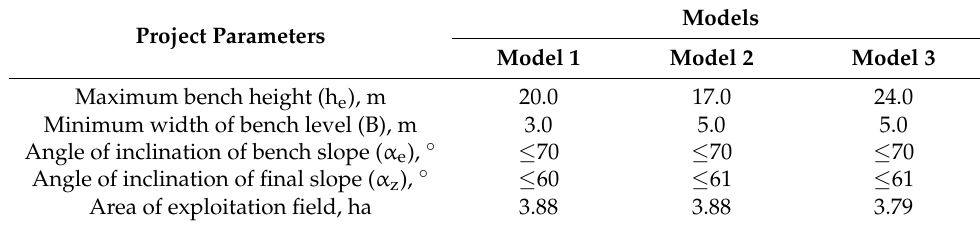
Table 6. Project parameters for the quarry “Tambura”.